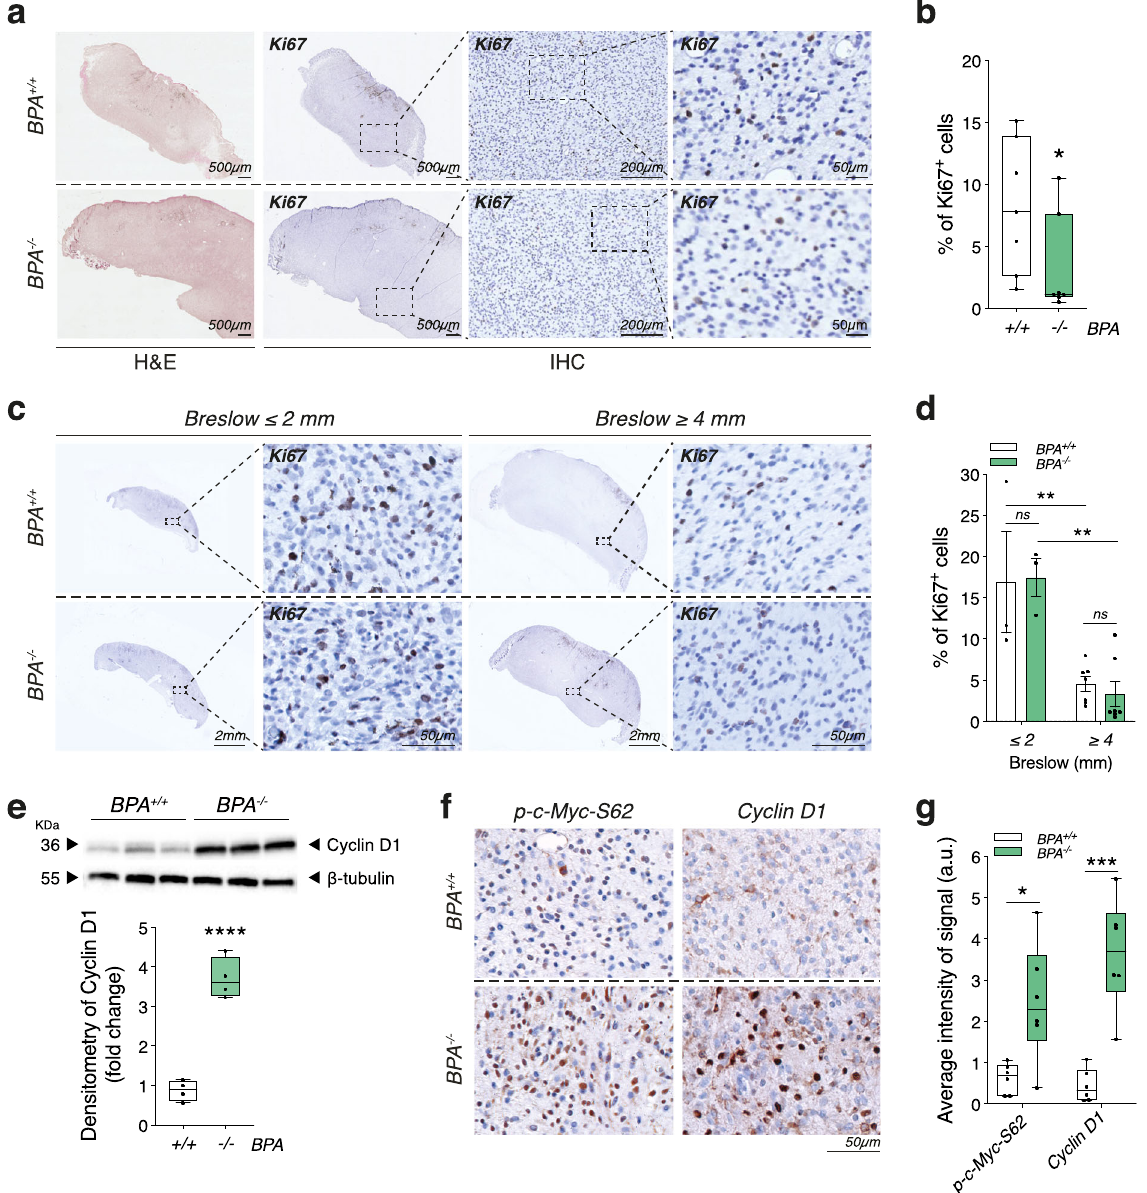
Fig. 2 Cell proliferation upon Ambra1 deletion. a Representative IHC staining of Ki67 on FFPE-tumor sections of BPA + / + ( n = 7) and BPA − / − ( n = 7) mice. b Quanti fi cation of the Ki67 + cells shown in a . Each data point represents one mouse and corresponds to the average ratio ± SEM of Ki67 + cells on nuclei count (at least three sections analyzed for each mouse) ( *p = 0.0262, two-tailed unpaired t -test, BPA − / − vs. BPA + / + ). c Representative IHC staining of Ki67 on tumors collected at Breslow ≤ 2 mm (average = 1.79 ± 0.28 mm; BPA + / + n = 3, BPA − / − n = 3) and ≥ 4 mm (average = 4.24 ± 0.69 mm; BPA + / + n = 7, BPA − / − n = 7). d Quanti fi cation of Ki67 + cells shown in c . Each data point represents one mouse and corresponds to the average ratio ± SEM of Ki67 + cells on nuclei count for each mouse ( **p = 0.0045 BPA + / + ≥ 4 mm vs. BPA + / + ≤ 2 mm; **p = 0.0015 BPA − / − ≥ 4 mm vs. BPA − / − ≤ 2 mm, two-way ANOVA). e Representative WB analysis and quanti fi cation (box plot) of Cyclin D1 in BPA + / + ( n = 4) and BPA − / − ( n = 4) bulk tumor lysates. ß-tubulin was used as loading control ( ****p < 0.0001, two-tailed unpaired t -test, BPA − / − vs. BPA + / + ) . f Representative IHC staining of Cyclin D1 and p-c- Myc-S62 in FFPE-tumor sections of BPA + / + ( n = 6) and BPA − / − ( n = 6) mice. g Quanti fi cation of Cyclin D1 and p-c-Myc-S62 signals shown in f ( *p = 0.0117; ***p = 0.0002, two-tailed unpaired t -test, BPA − / − vs . BPA + / + ). Box-and-whisker plots shown in b , e , g represent values from minimum to maximum. Top and bottom whiskers denote upper (Q 3 ) and lower (Q 1 ) quartiles, respectively. Boxes refer to interquartile ranges. Medians are denoted as horizontal line in the middle of the